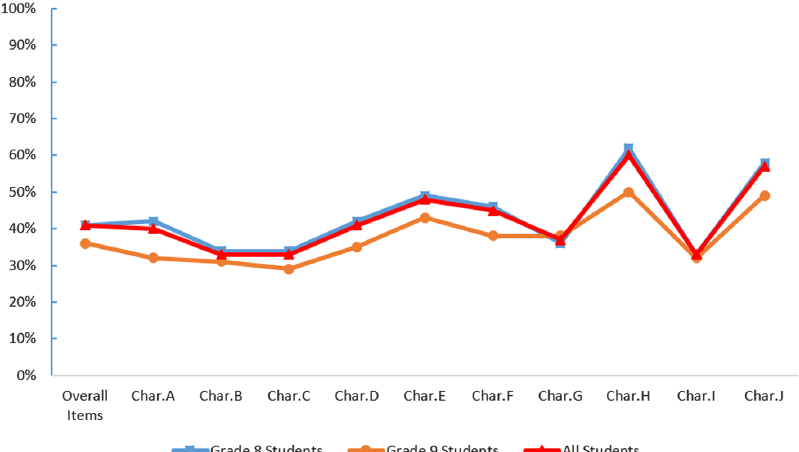
FIG. 1. Average percentage of correctness for each of the materialistic properties in the sound substance scheme, of all students and according to grade level (Char.A, Sound is invisible material; Char.B, Sound has a corpuscular nature; Char.C, Sound is pushable by objects; Char.D, Sound is pushable by medium; Char.E, Sound is frictional; Char.F, Sound is containable; Char.G, Sound is consumable; Char.H, Sound is gravity sensitive; Char.I, Hearing is influenced by the sound particle ’ s size or number; Char.J, Sound is able to pass in a